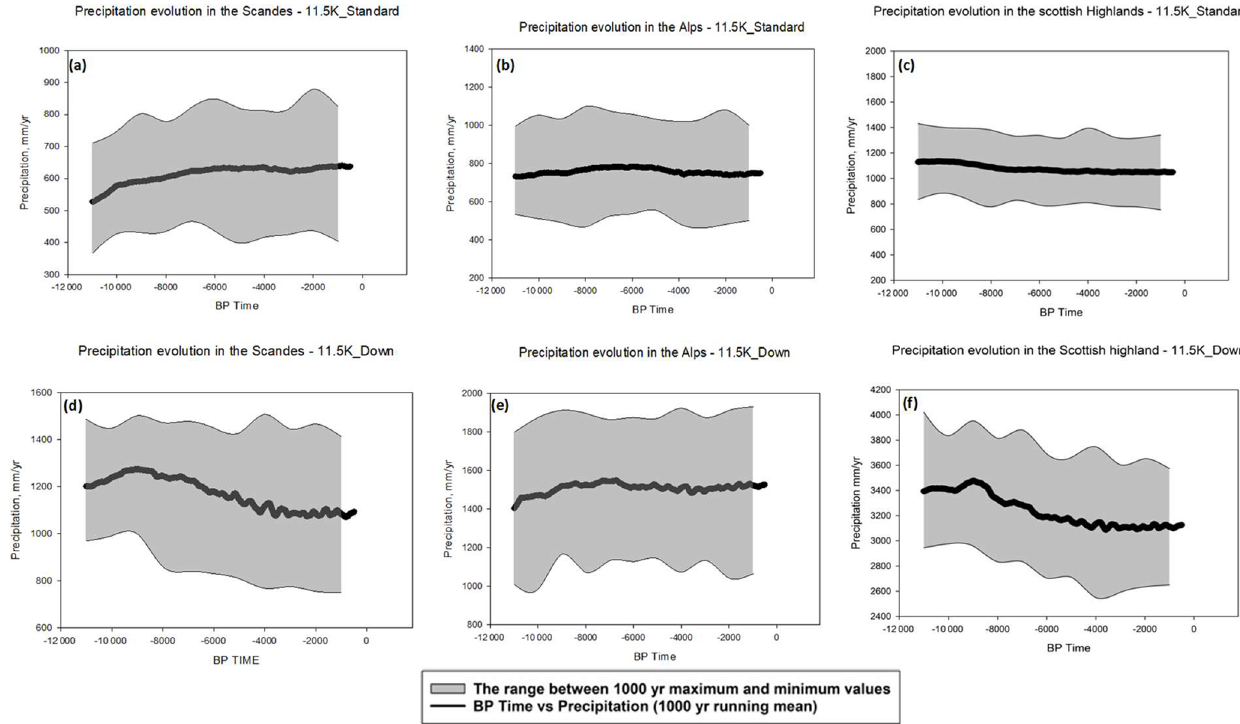
Figure 6. Regional annual precipitation evolution during the Holocene in some mountainous regions in Europe for both 11.5K_Standard and 11.5K_Down in the Scandes mountains (a, d) , Alps (b, e) , and Scottish Highlands (c, f) . Grey-shaded areas represent the range between the maximum and minimum values in the transient simulations, and the black curve shows the 1000-year running mean of precipitation (in mmyr − 1